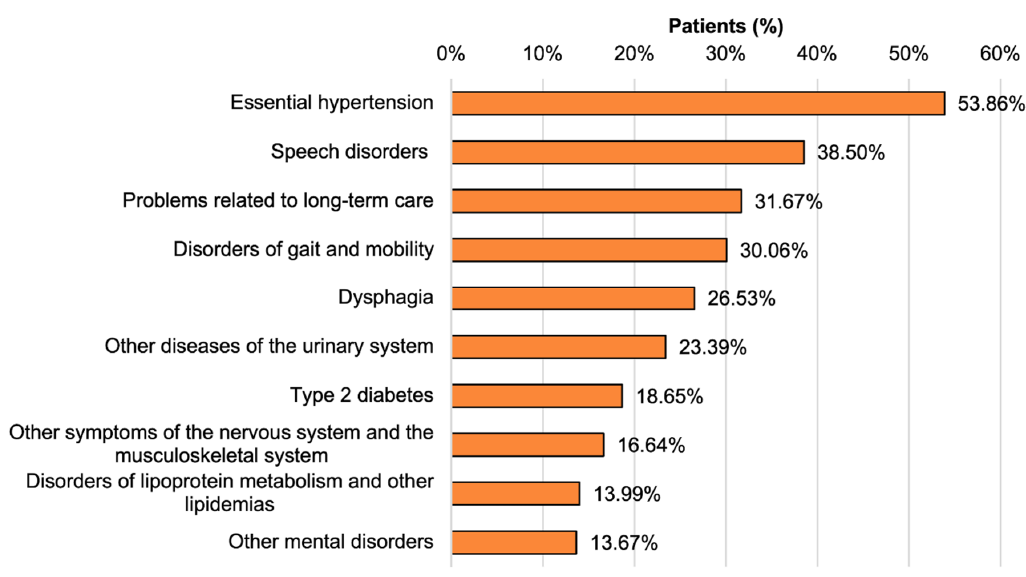
Figure 4. Prevalence of the 10 most frequent comorbidities among patients with PSP (G23.1) in 2017. Importantly, essential hypertension was diagnosed in 54% of the patients. Comorbidities of neuro-psychiatrical disorders (speech disorders, gait and motility disorders, dysphagia, symptoms of the nervous and musculoskeletal system and other mental disorders) were present in a range from 14% to 39% for all patients. Metabolic disorders such as type 2 diabetes mellitus and disorders of lipoprotein metabolism were found in 19% and 14% of patients, respectively. In comparison to the ratio of comorbidities in patients within the German DRG diagnostic category Primary Parkinson’s syndrome (G20.-) in 2017, PSP patients (G23.1) showed speech disorders (38.50 % vs. 22.92%) and dysphagia (26.53% vs. 11.66%) substantially more often, but motor dysfunction less often (12.94% vs. 23.75%) (Table S2). The most frequently coded main diagnoses with G23.1 or G23.- as secondary diagnosis in 2017 were pneumonia caused by solid and liquid substances, primary Parkinson´s disease, glaucoma, pneumonia with not specified pathogen, hypovolemia, intracranial injuries, other diseases of the urinary system, epilepsy, stroke and sepsis (Tables S3 and S4). The distribution of comorbidities for patients with a diagnosis in the G23.- principal category was similar to the comorbidity distribution for patients with diagnosis G23.1, including cardiovascular, neurological, muscular and urological disorders. Essential hypertension was diagnosed in 48% of these patients. Comorbidities in the form of neuro-psychiatrical disorders (speech disorders, gait and motility disorders, dysphagia, other mental disorders due to damage or dysfunction of the brain or physical illness and symptoms of the nervous and musculoskeletal system) were present in a range from 13% to 37% of the patients (Figure 5).